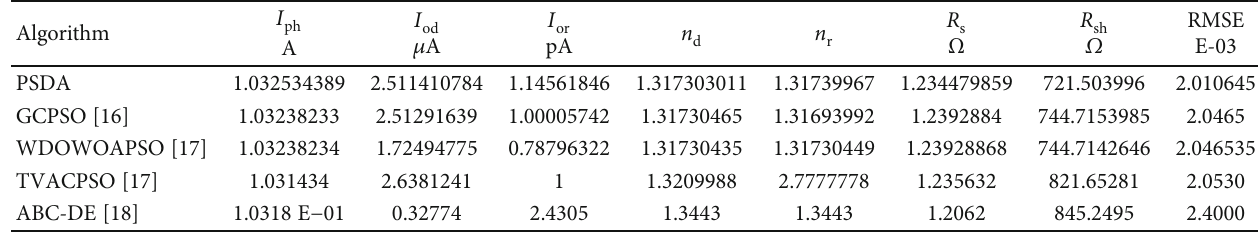
Table 2: The seven parameters of the PWP201 photovoltaic